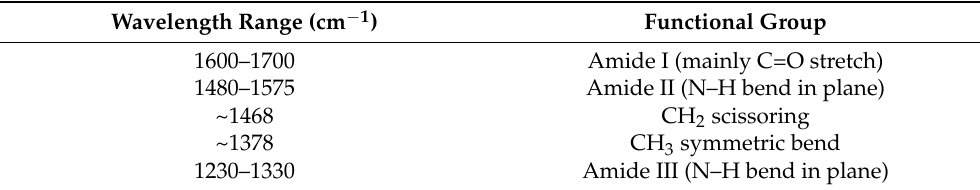
Table 1. Band assignments of the main infrared active vibrations of keratin